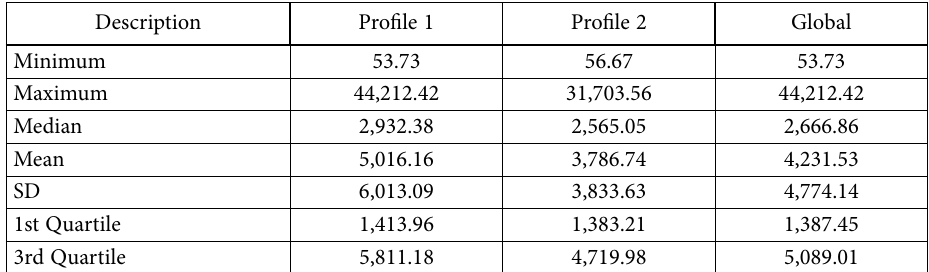
Table 5. Description of C (€) (source: own elaboration from Banco de España, 2019)